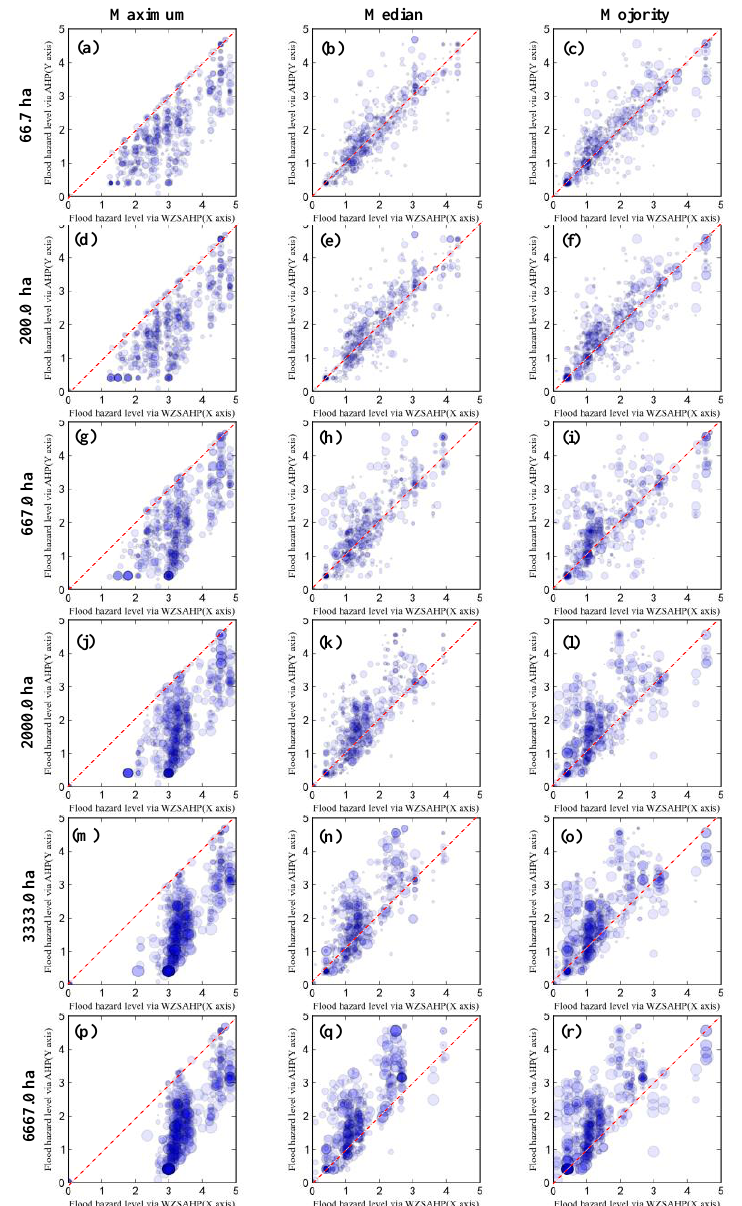
Figure 12. Scatter diagrams of flood hazard indexes distribution sampled by WZSAHP-RC via D8 delimitated sub-watershed a basic unit (WZSAHP-RC-D8) and AHP methods. The subfigures ( a – r ) used the flood hazard index derived by WZSAHP-RC-D8 as X-axis and using flood hazard index derived by AHP as Y-axis.